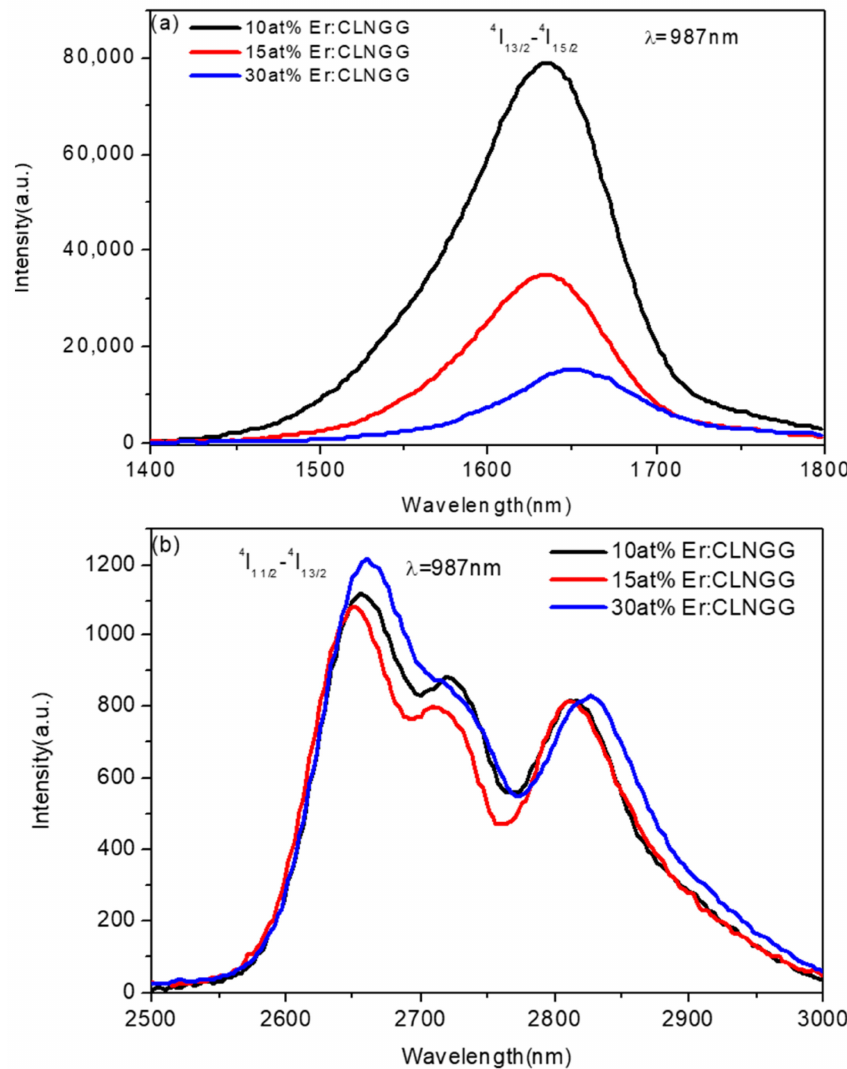
Figure 9. Emission spectra of Er:CLNGG ranging from ( a ) 1400–1800 nm ( b ) 2500–3000 nm under the excitation of 987